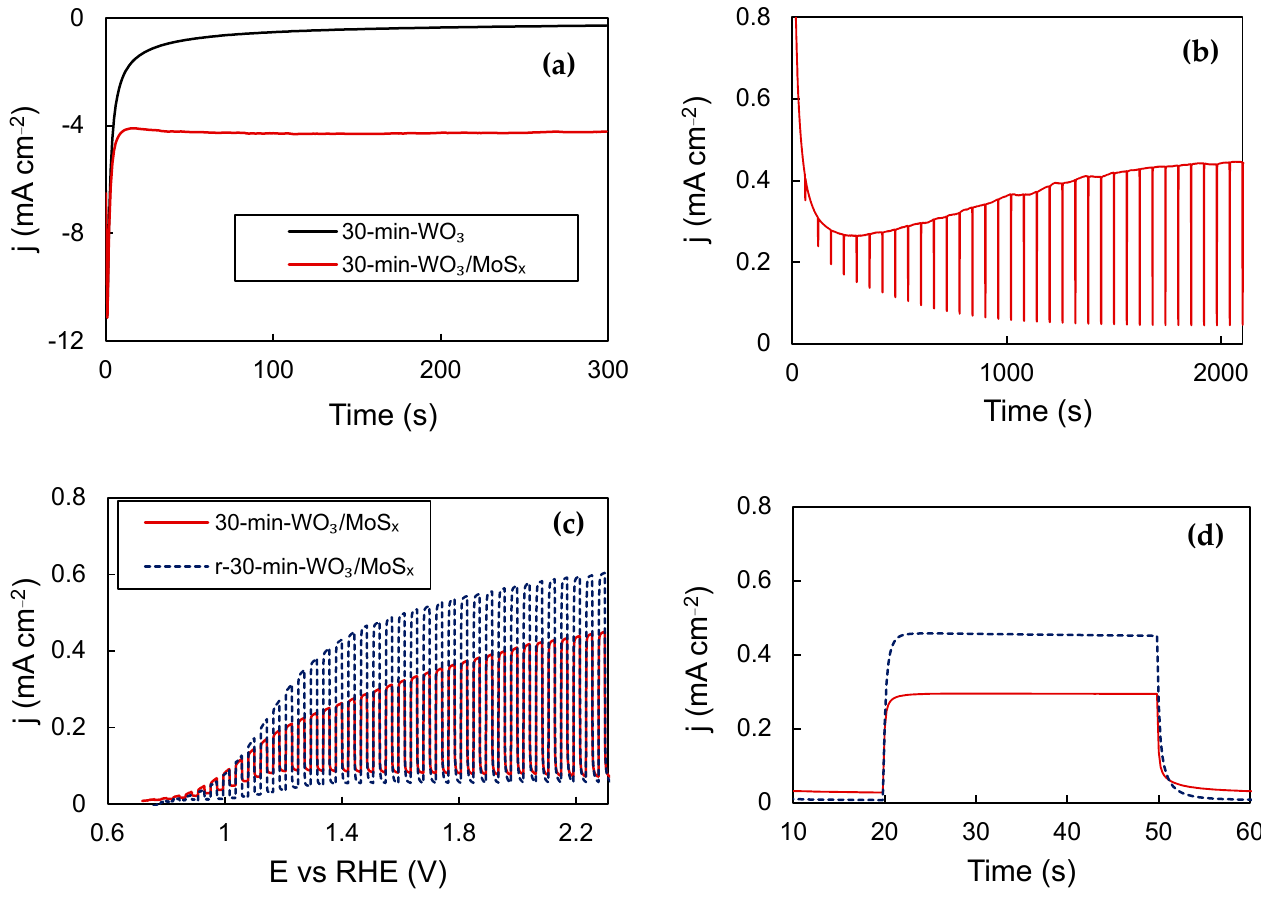
Figure 8. Chronoamperometric curves for WO 3 /MoS x and WO 3 reduction at − 0.28 V ( a ); activation curve of reduced 30-min-WO 3 /MoS x ( b ); chopped-UV LSV curves ( c ); steady-state photocurrent pulses ( d ). See Table 1 for more details.